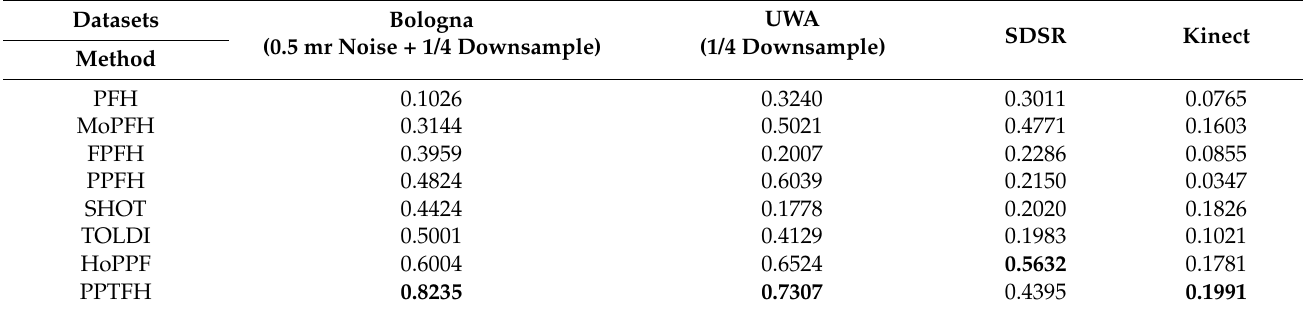
Figure 8. AUC pr results on different nuisances. ( a ) Bologna dataset with different noise levels and 1/4 downsample. ( b ) Bologna dataset with mesh resolution variation. ( c ) UWA dataset for different clutter rates. ( d ) UWA dataset for different occlusion rates. Table 2. Descriptiveness (AUC pr ) for different